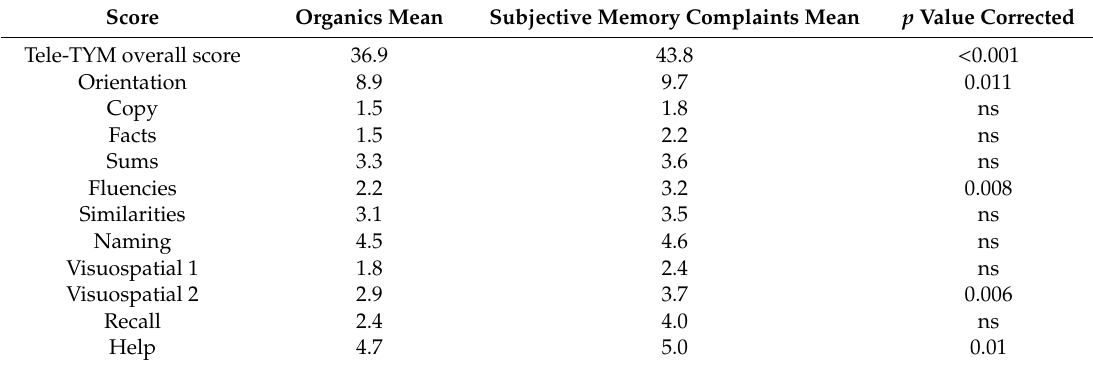
Table 4. Results of the Telephone TYM study.